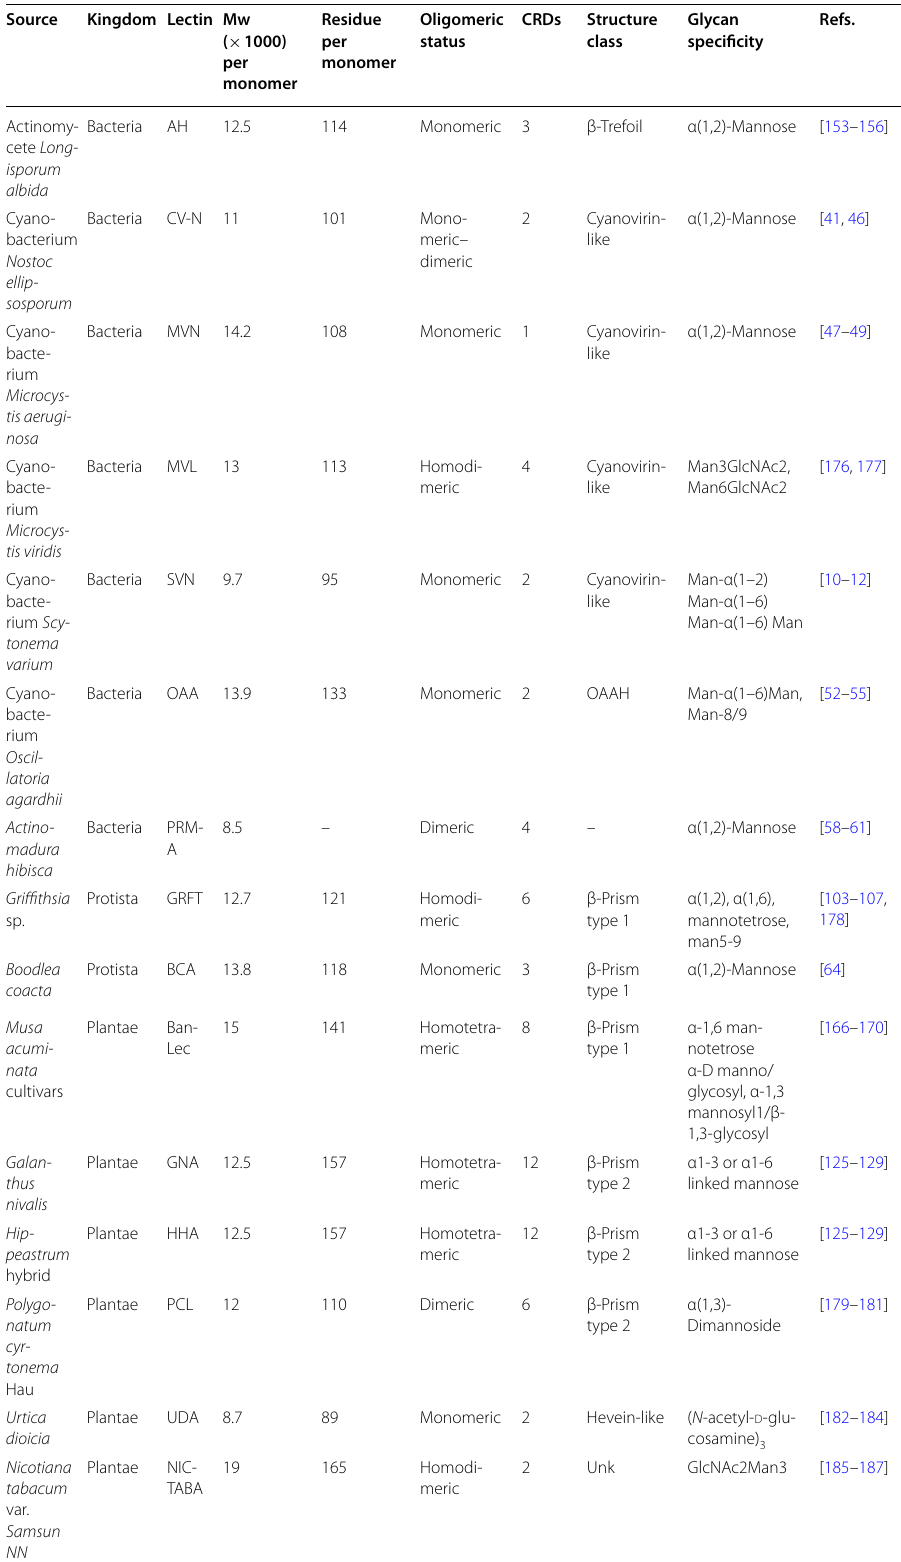
Table 1 General features of antiviral lectins